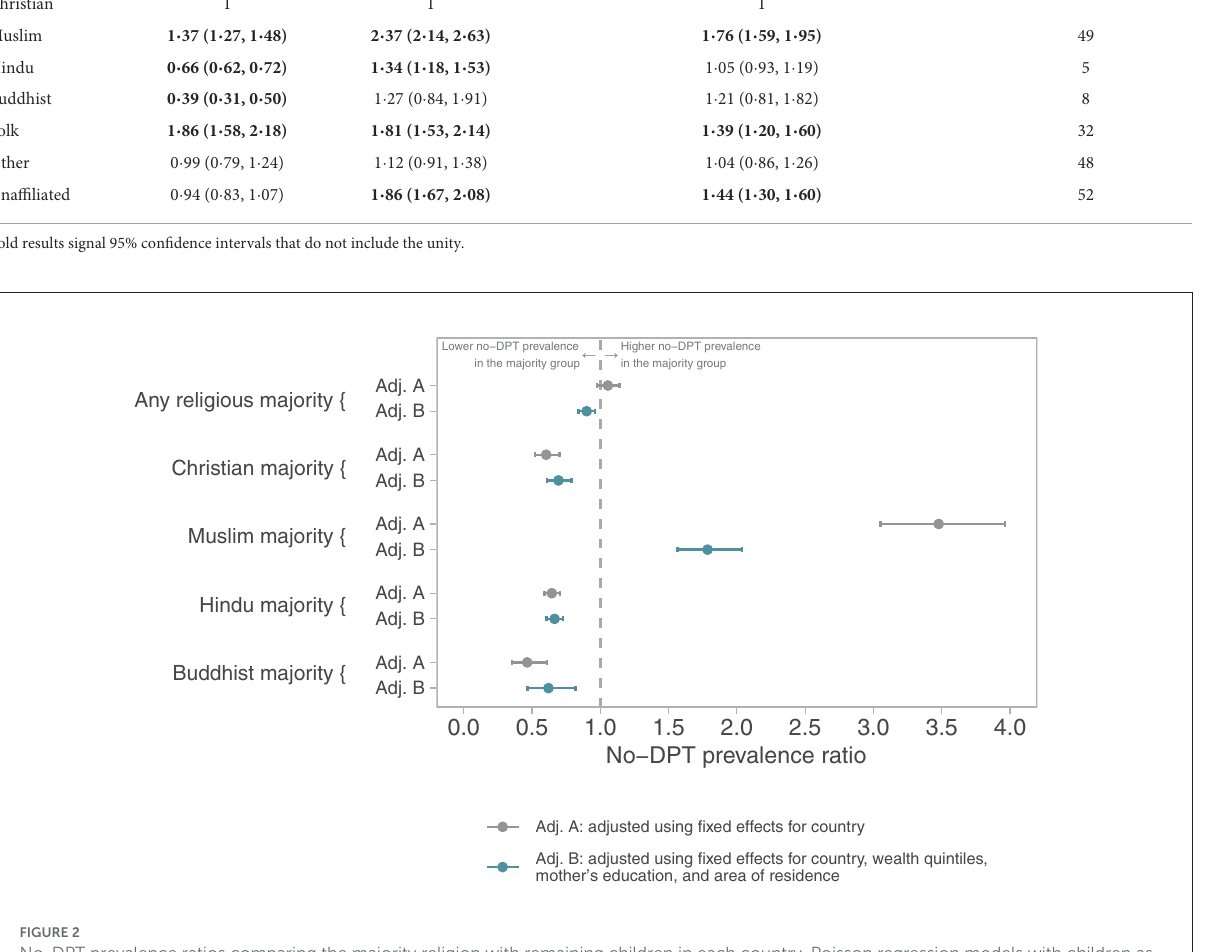
TABLE 1 Poisson regression analyses with children as the units of analyses, including fixed effects for countries and covariates. Religious group No-DPT prevalence ratio (95%CI) Number of countries with data Crude Adjusted using fixed Adjusted using individual variables and effects for country fixed effects for country